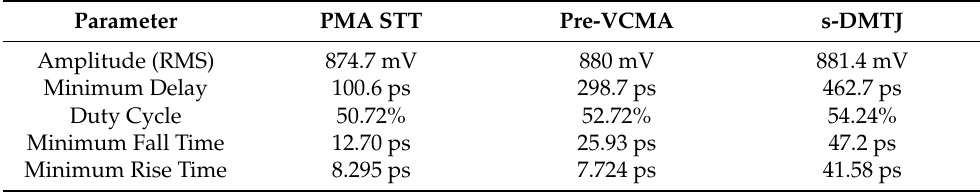
Table 4. Transient Measurements data for different 2T MTJ devices in the test